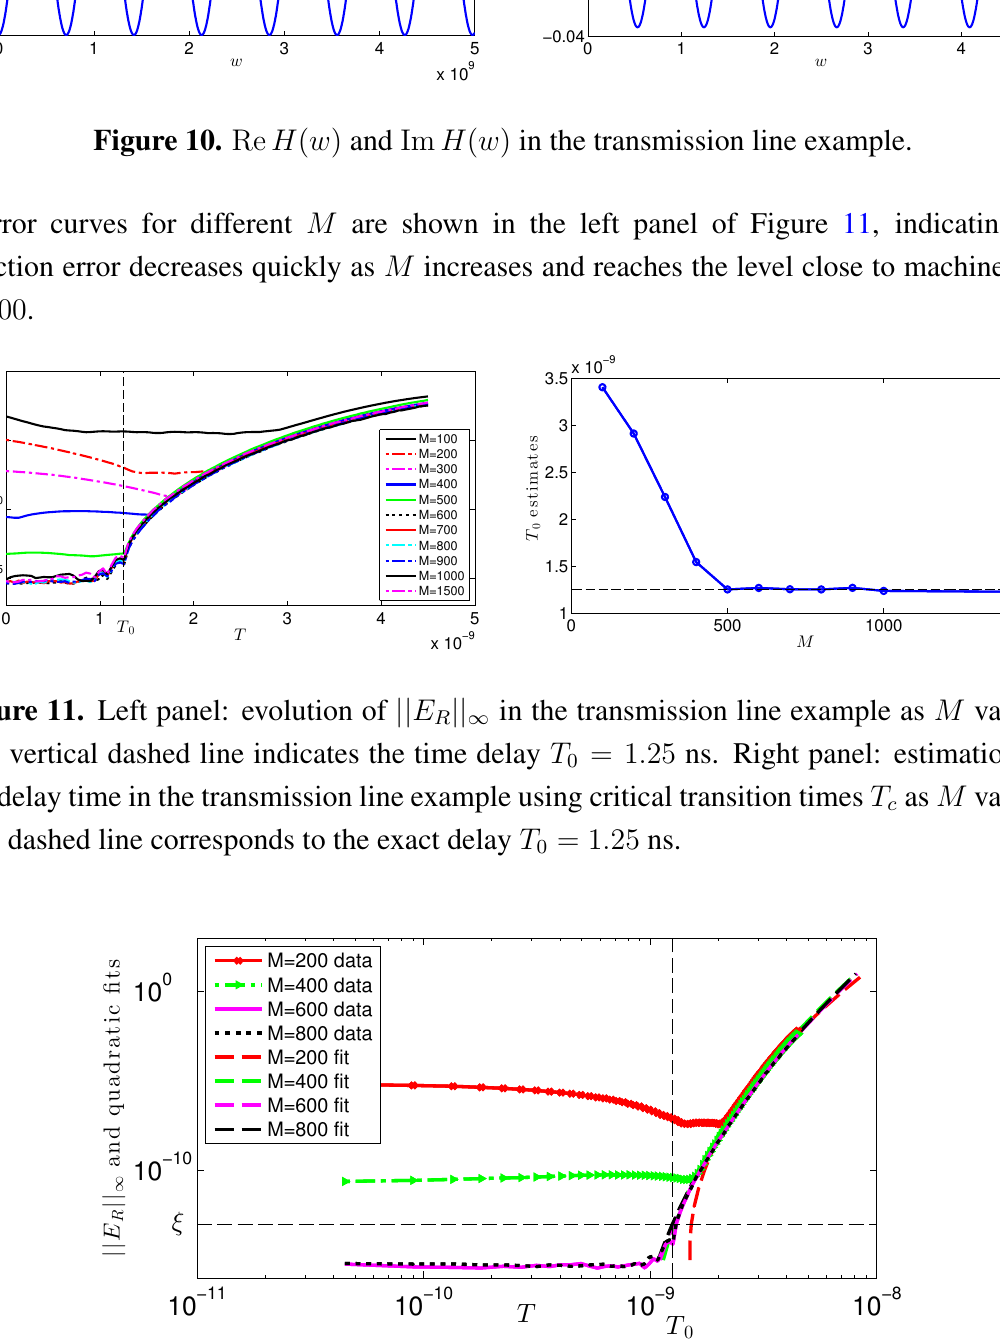
|| Figure 12. || E in the transmission line example with M = 200 , 400, 600 and 800 R ∞ together with their quadratic fits. The vertical dashed line indicates the exact time delay T = 1 . 25 ns, while the horizontal dashed line indicates the level of filtering of singular 0 values given by ξ = 10 − 13